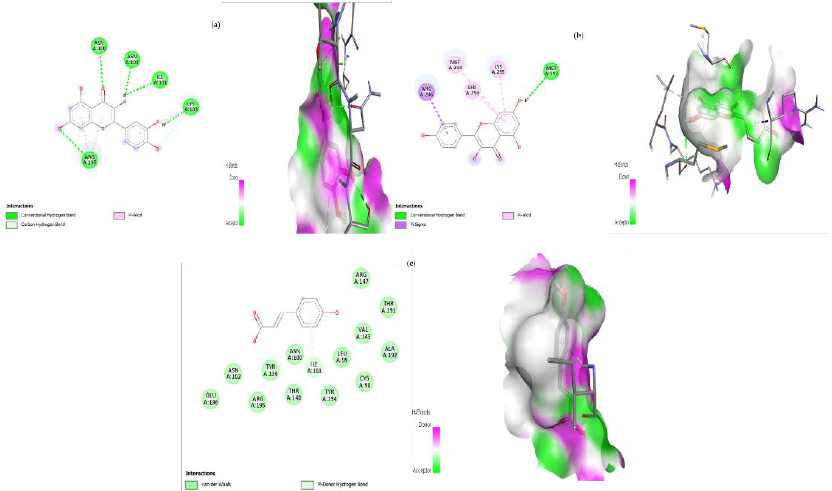
Figure 12. Lead compounds and their interaction with IRS-2 at the molecular level. ( a ) Quercetin; ( b ) kaempferol; ( c ) p-coumaric acid .